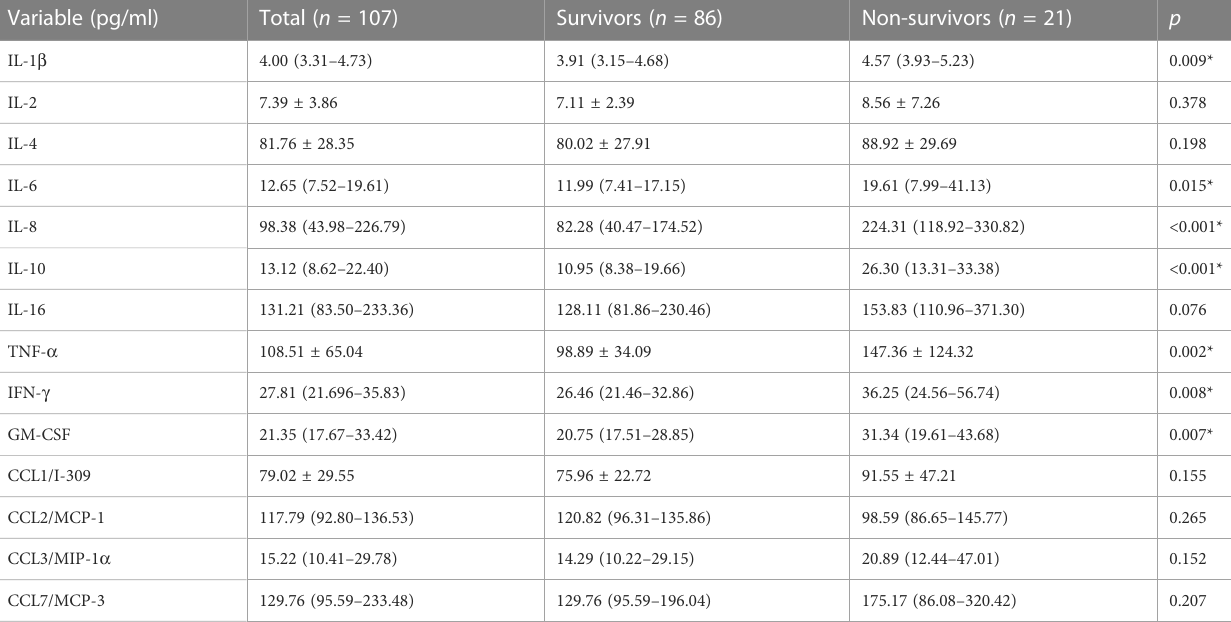
TABLE 2 Analysis of the in fl ammatory cytokine and chemokine pro fi les of the two groups. Variable (pg/ml) Total ( n = 107) Survivors ( n = 86) Non-survivors ( n =